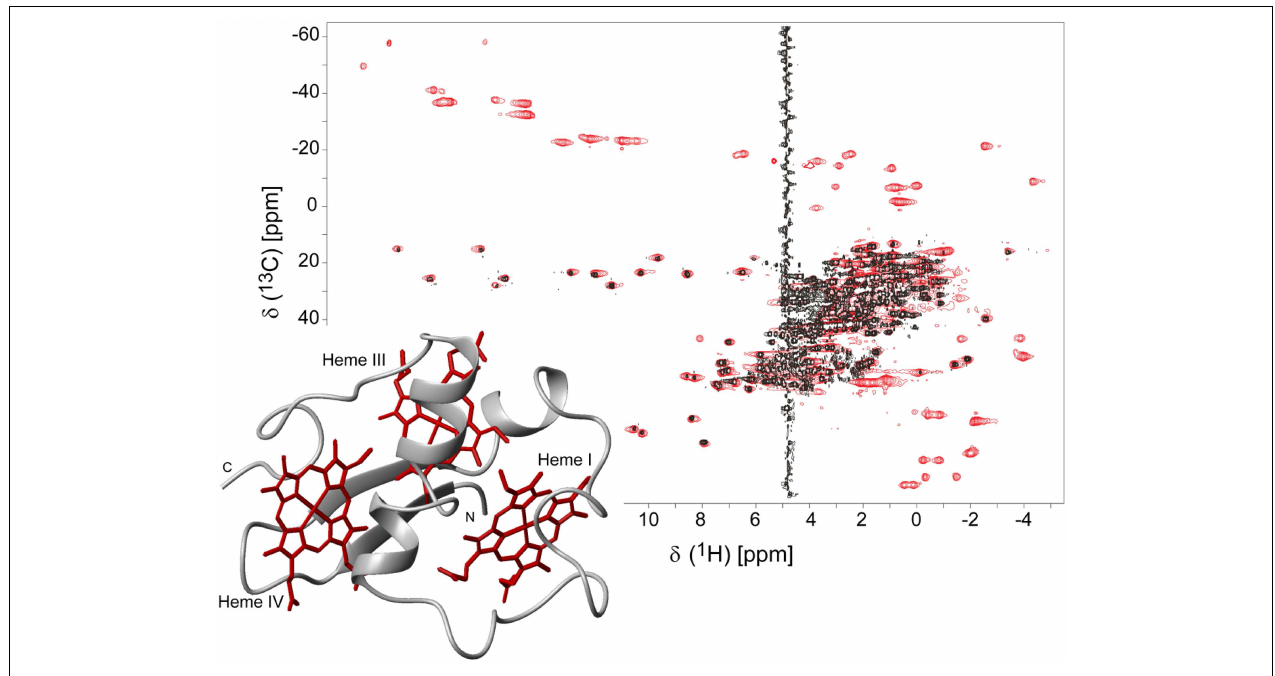
NMR solution structure of PpcA (PDB code 2LDO, Morgado et al., 2012b). The peptide chain and the hemes are colored gray and red, respectively. The hemes are numbered I, III and IV, a designation that derives from the superimposition of the hemes of PpcA and other cytochromes c 7 with those of the structurally homologous tetraheme cytochromes c 3